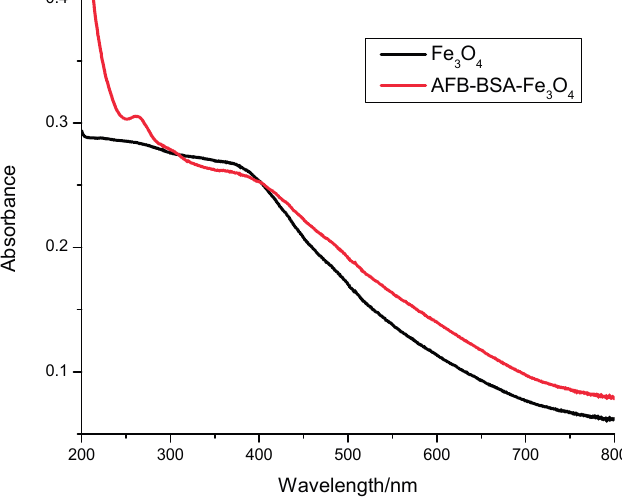
Figure 1. UV-Vis absorption spectra of Fe 3 O 4 and AFB-BSA-Fe 3 O 4 particles.